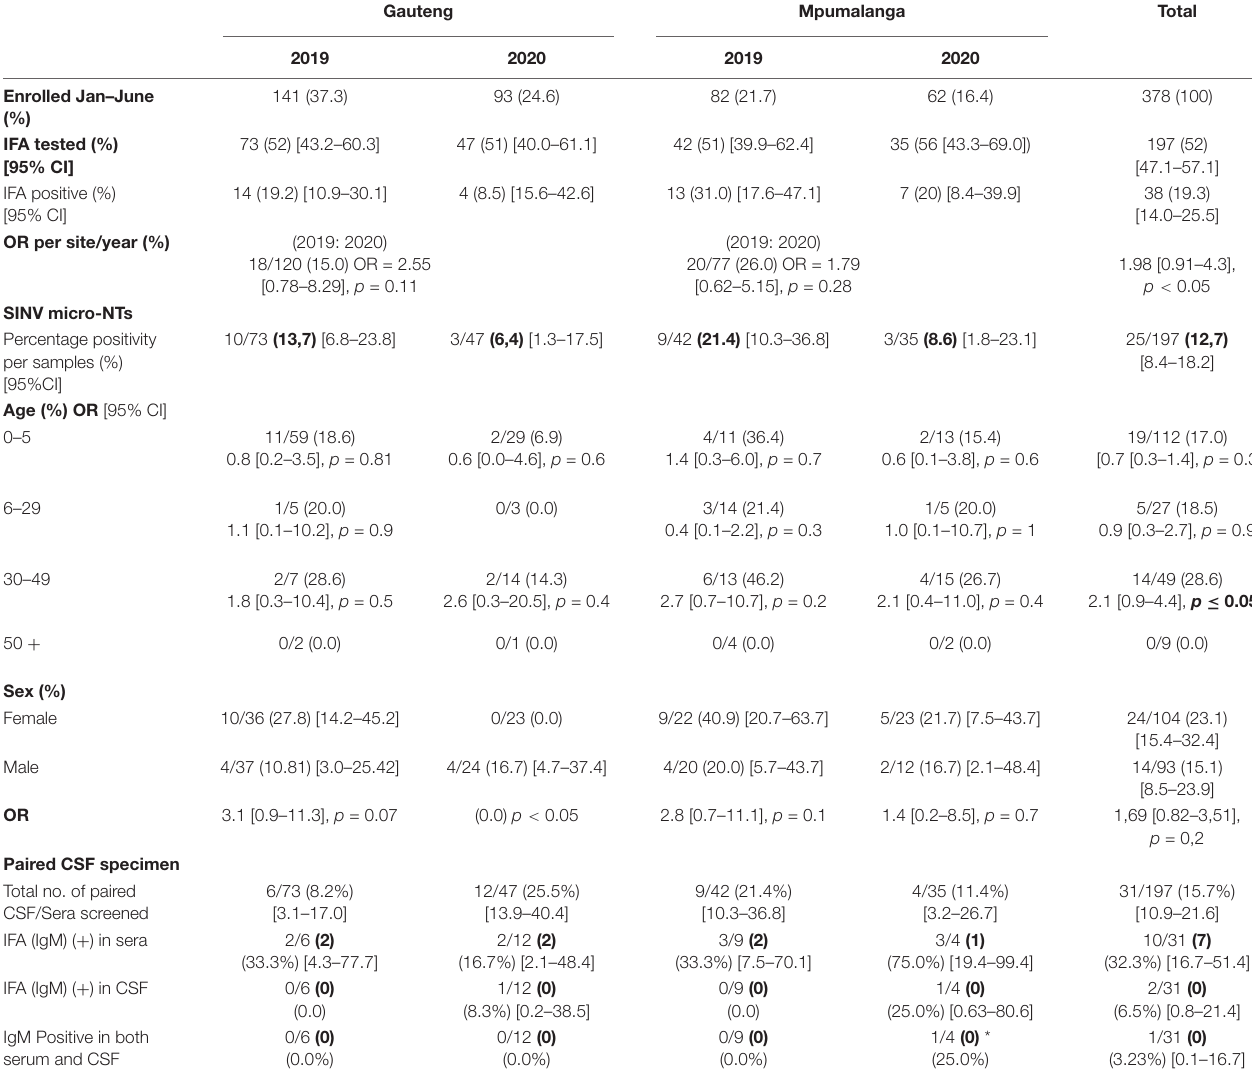
TABLE 2 | Multiplex PCR, IFA (IgM), and Neutralization assay results on patients tested from 2019 to